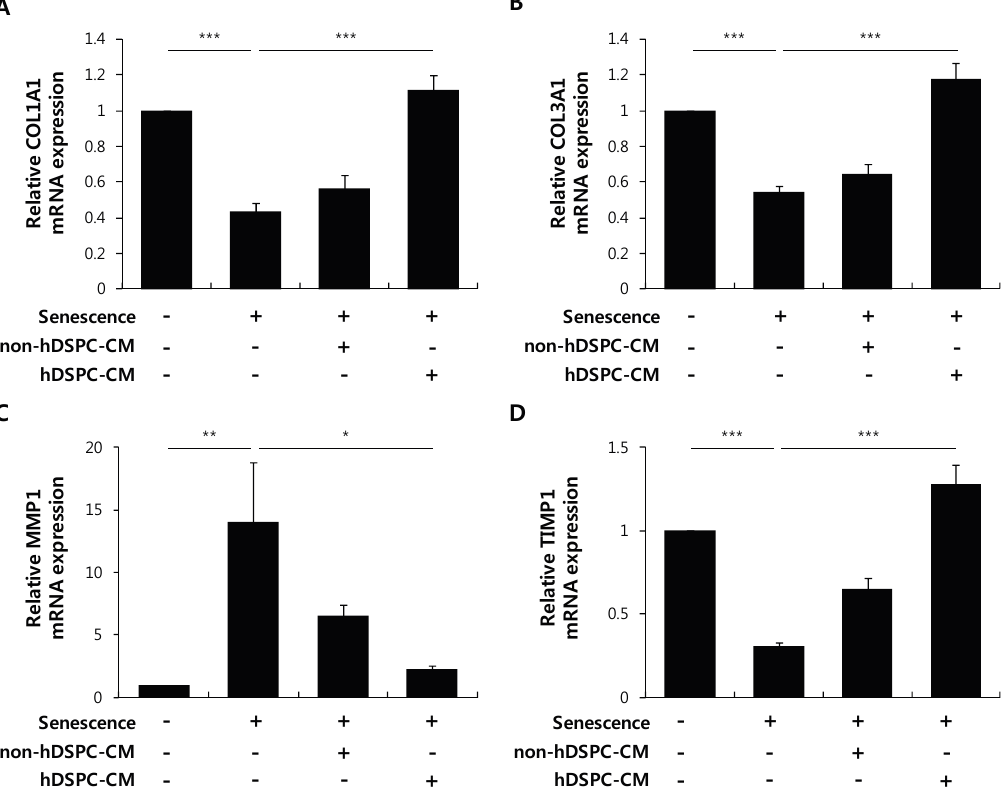
Figure 3. hDSPC-CM restored the expression of specific dermal makers in senescent fibroblasts. Senescent fibroblasts were treated with either hDSPC-CM or non-hDSPC-CM for 24 h. Real-time RT-PCR analysis was performed to quantify the expression levels of COL1A1 ( A ); COL3A1 ( B ); MMP1 ( C ); and TIMP1 ( D ). The graphs depict means ±